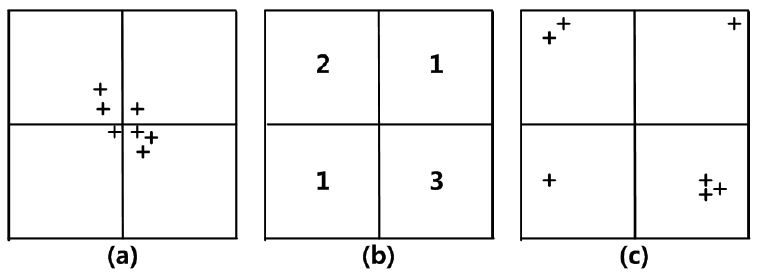
Figure 2. The spatial position of data points is ignored due to the counting method. ( a , c ) The distribution of data points on the grid; ( b ) Spatial Position on Grid